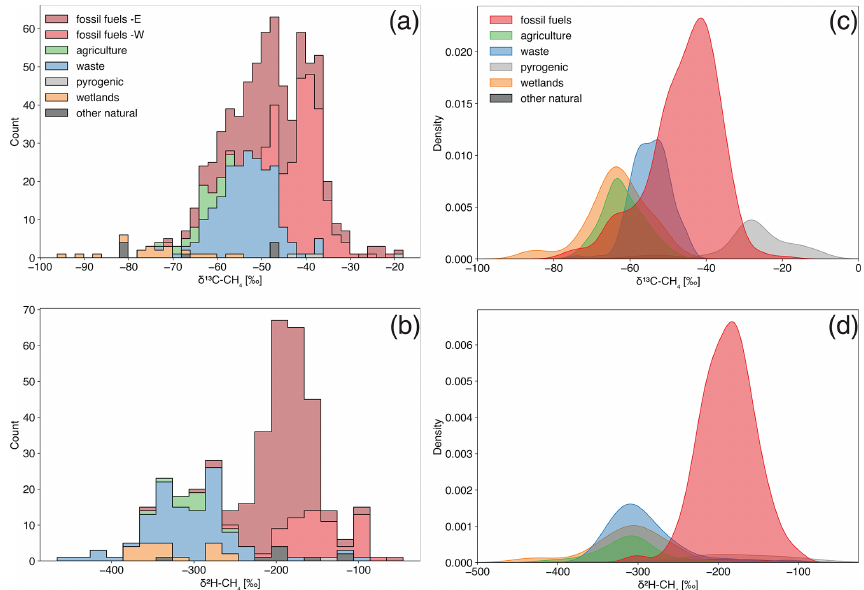
Figure 5. Distribution of δ 13 C (a, c) and δ 2 H (b, d) in CH 4 for different source categories. (a) Single measurements reported in the EMID (absolute numbers). “fossil fuels -E” shows fossil fuels data from Poland and Romania, and “fossil fuels -W” from the UK, the Netherlands, Germany, and France. (b) Measured locations in all datasets (Sherwood et al., 2021), with EMID locations and additional literature) (normalised probability density). “Agriculture” represents ruminants and rice paddies emissions. Table 5. CH 4 isotopic source signatures assigned to the fossil fuel-related emissions in past global-scale models (not an exhaustive list). Reference δ 13 C VPDB [‰] δ 2 H VSMOW [‰] Gupta et al. (1996), Tyler et al. (2007) − 38/ − 37 a − 175 Neef et al. (2010), Monteil et al. (2011) − 40/ − 35 a Rigby et al. (2012) − 40